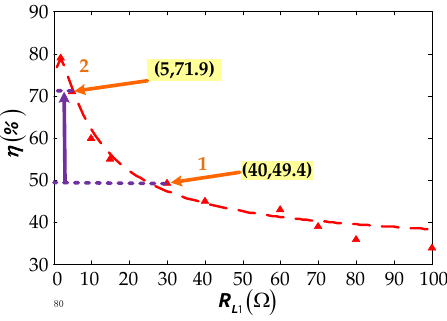
Figure 12. Transfer efficiency versus adjustable loads when N = 3.